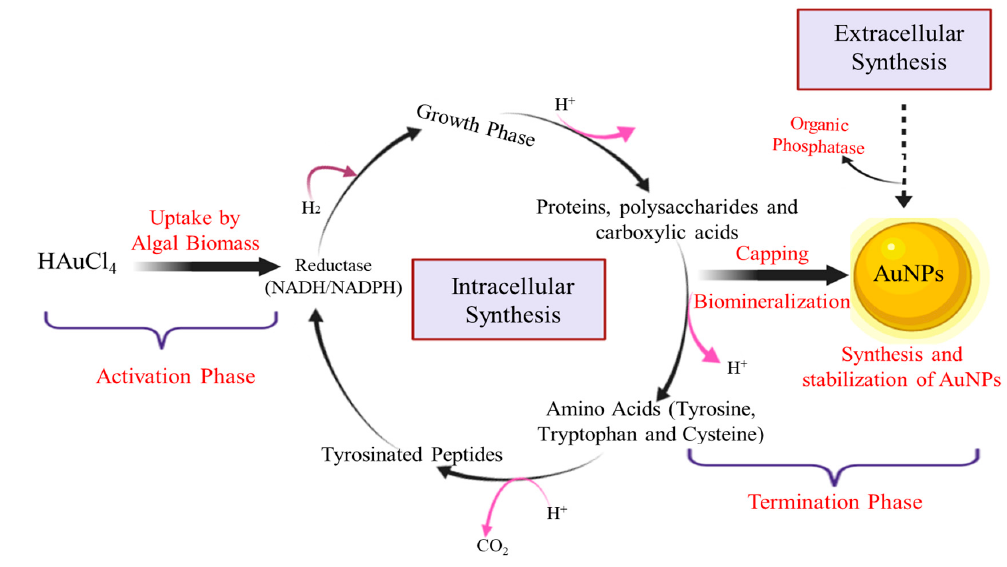
Figure 3. Schematic illustration of mechanism involved in extracellular and intracellular synthesis of algae-mediated gold nanoparticles